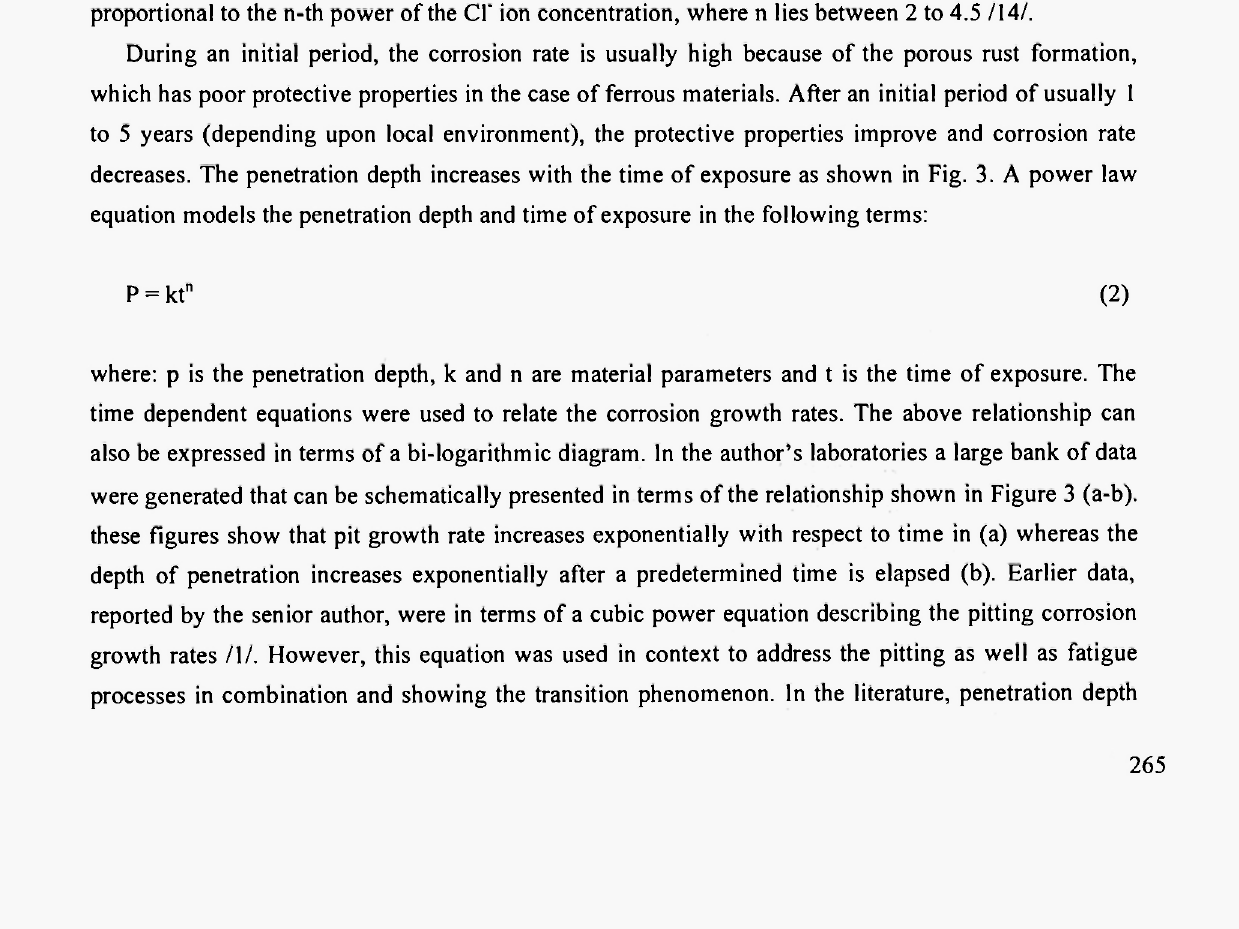
Fig. 2: Pitting corrosion fatigue cycles to pit